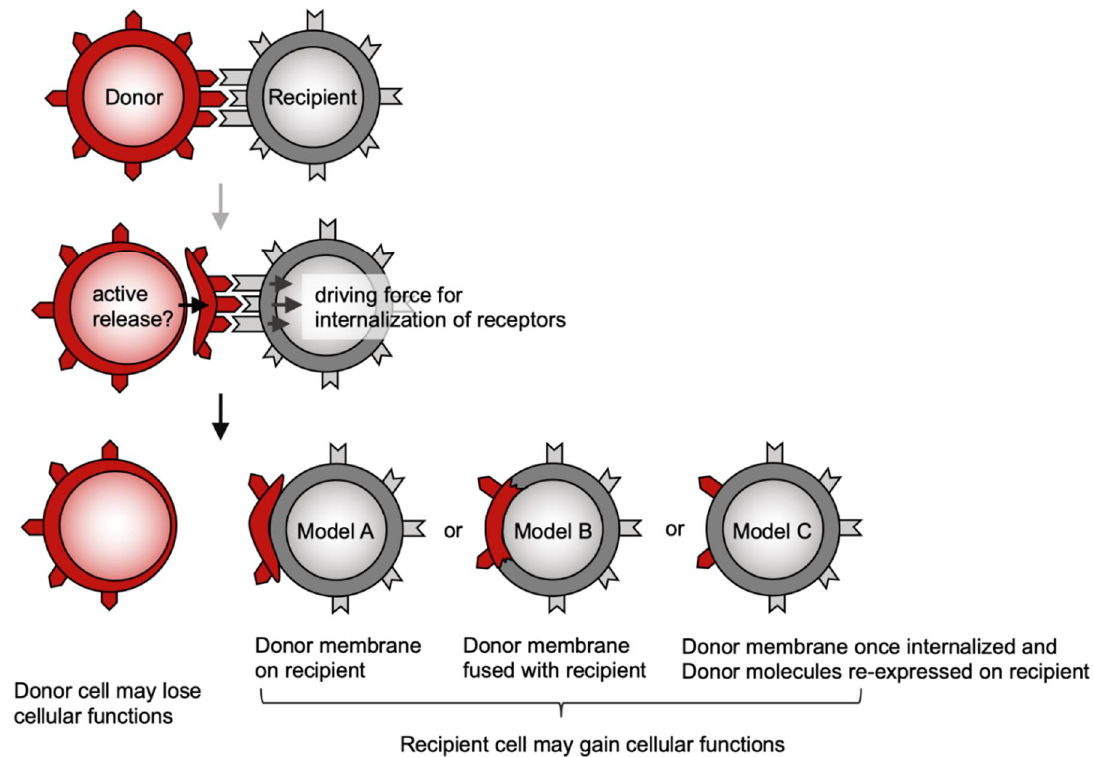
Figure 1. Principal models of trogocytosis. When two types of cells make physical contact via receptor-ligand interactions, the driving force for internalization of receptors expressed on one cell (here called recipient) co-opts ligand-containing plasma membrane fragments from the other cell (here called donor). Not only are receptors and ligands involved in this process, but adhesion molecules also play a role. The donor cells lose membrane molecules and their cellular functions, whereas the recipient cells gain donor-derived membrane molecules and functions. It is unclear how donor-derived mol- ecules exist on recipient cells. The three hypothesized models are shown as A, B, and C.